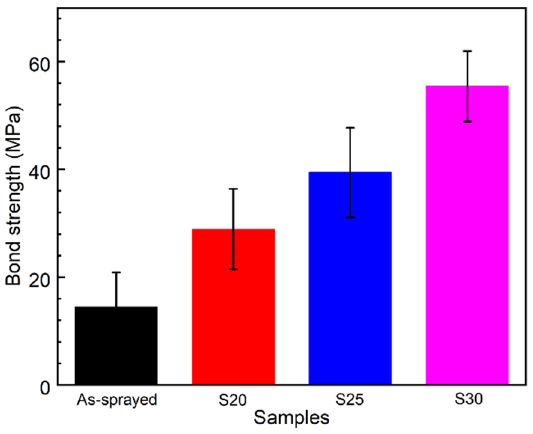
Figure 7. Bond strength of the as-sprayed NiCrBSi, S20, S25 and S30 samples. S20, S25, and S30 indicate the as-sprayed NiCrBSi coatings remelted at 20 kW, 25 kW, and 30 kW.